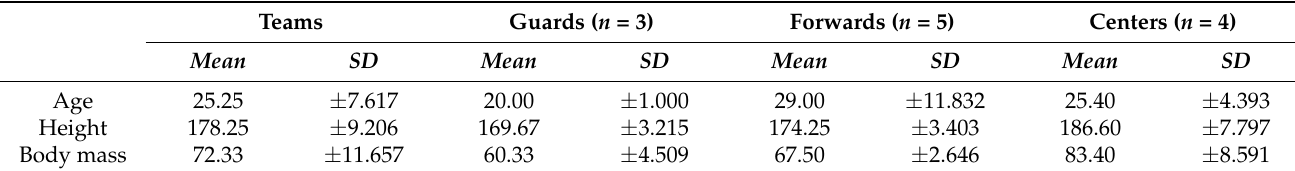
Table 2. Sociodemographic and body composition characteristics of the sample.